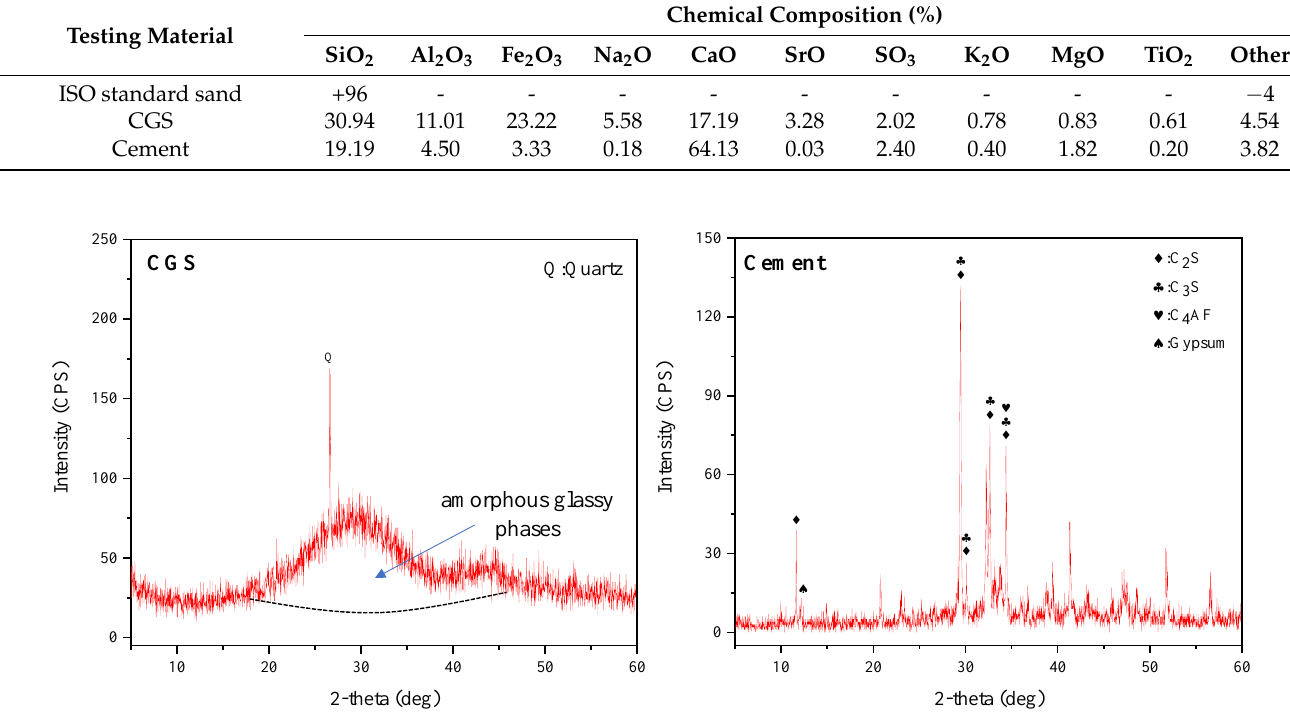
Table 1. Chemical composition of the test material.